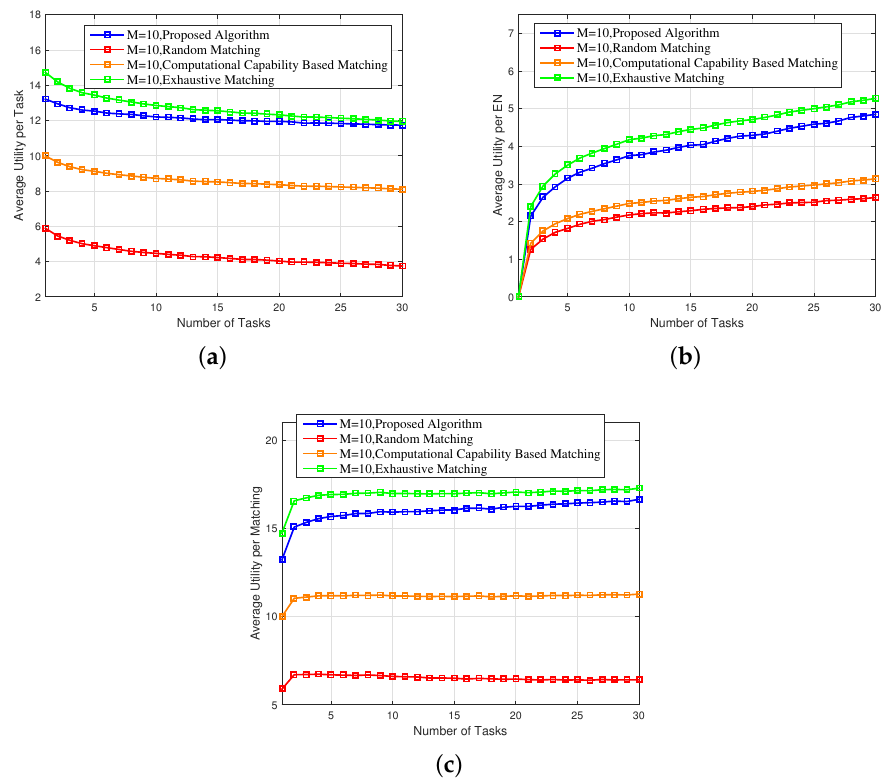
Figure 4. ( a ) Average utility per task, ( b ) average utility per EN, and ( c ) average utility per matching of the proposed scheme versus the random matching, CCBM, and exhaustive matching